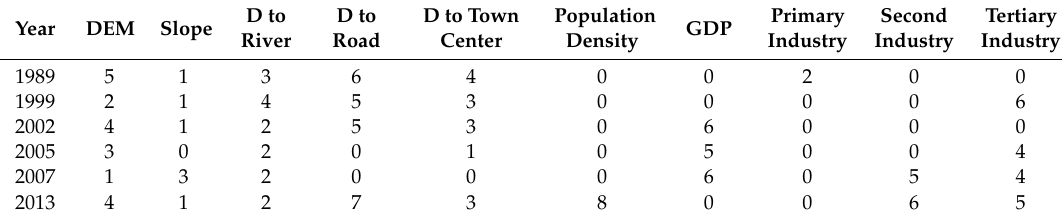
Table 4. Significant variables of the logistic regression for built-up areas in di ff erent years.